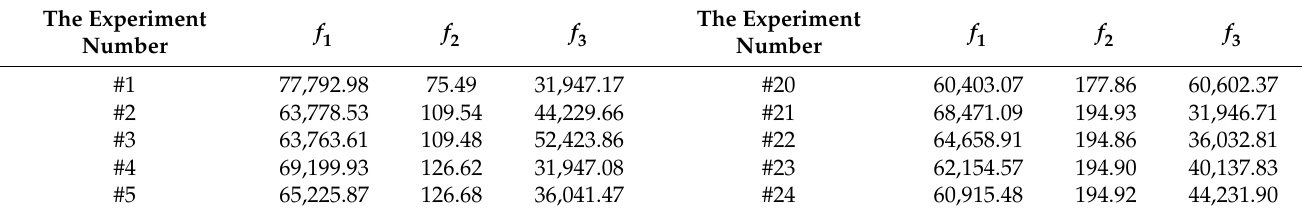
Table A1. Pareto Optimal Solutions for the Case